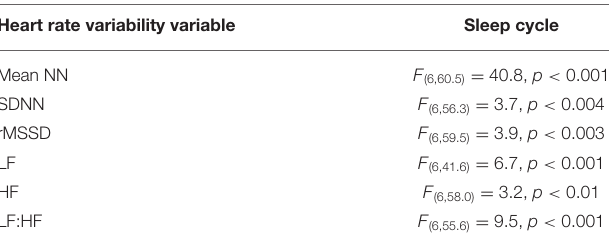
TABLE 3 | Fixed effects values for sleep cycle. Heart rate variability variable Sleep